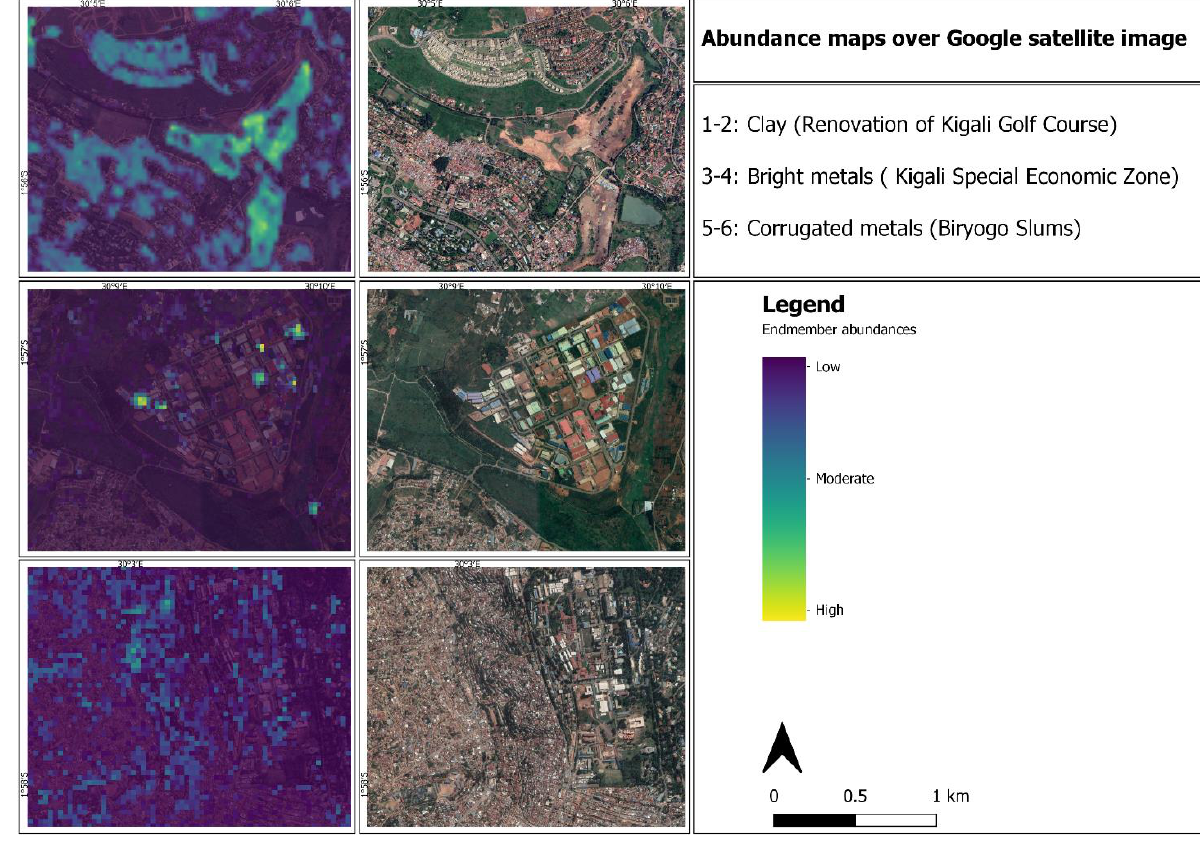
Figure 8: Abundance maps over Google satellite images